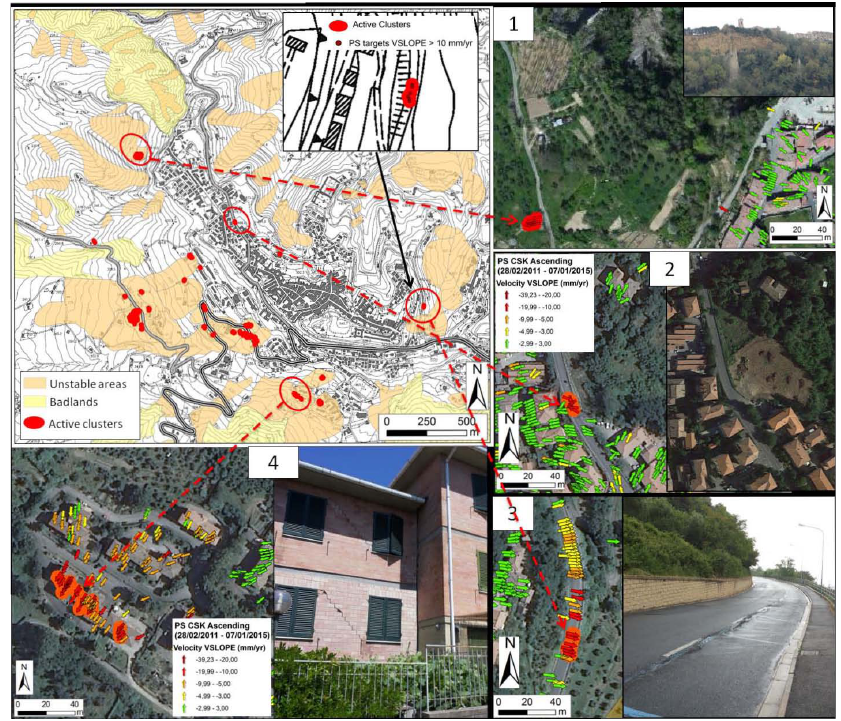
Figure 6. Detected “active clusters” [62] over Volterra area, overlapped on the spatial distribution of mapped unstable areas and badlands. The four close-up windows show four chosen examples of “active clusters” including the velocity map (V SLOPE data are displayed as colored arrows) and photos of each chosen site.